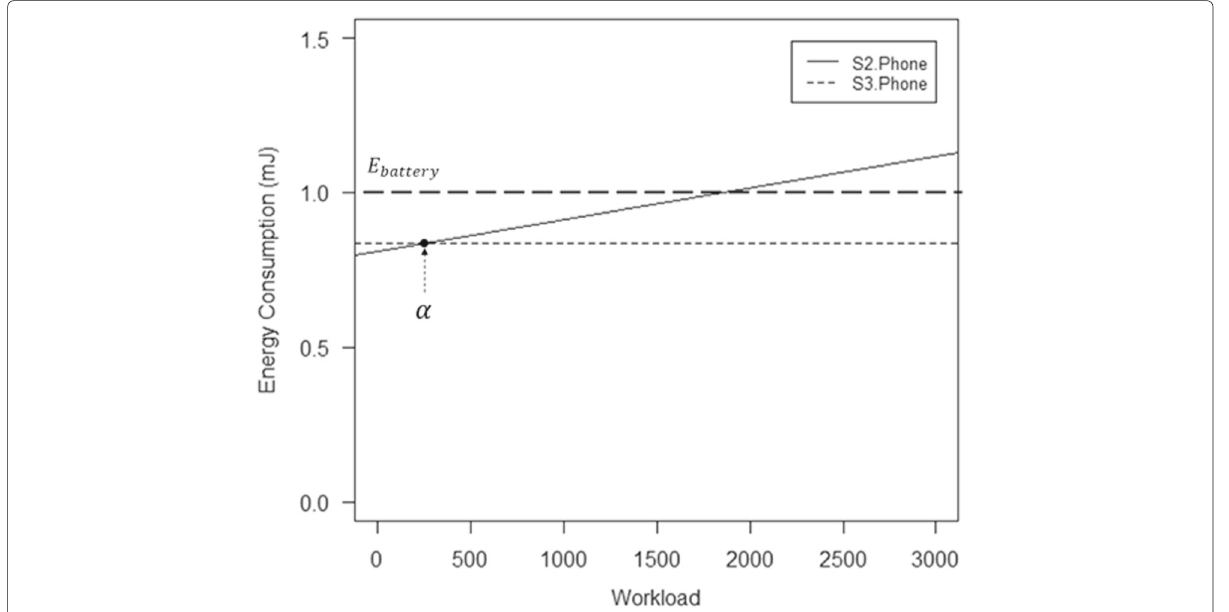
Fig. 10 Comparison of energy consumption of smartphone according to